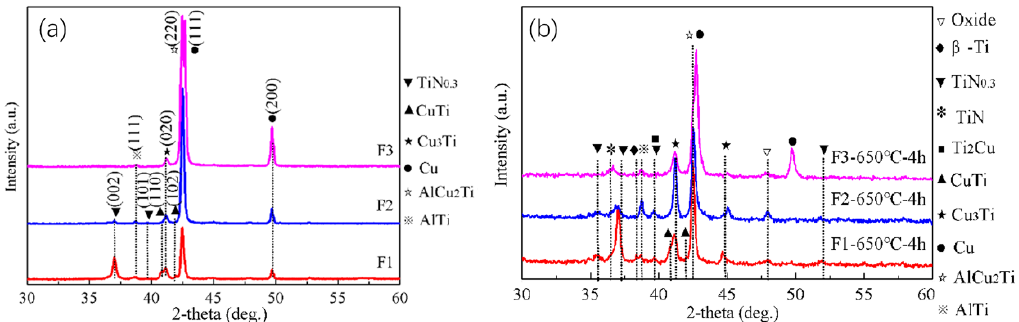
Figure 2. ( a ) XRD results of the Cu-Ti films after plasma nitriding at 650 ◦ C for 4 h, ( b ) GIXRD results of the Cu-Ti films after plasma nitriding at 650 ◦ C for 4